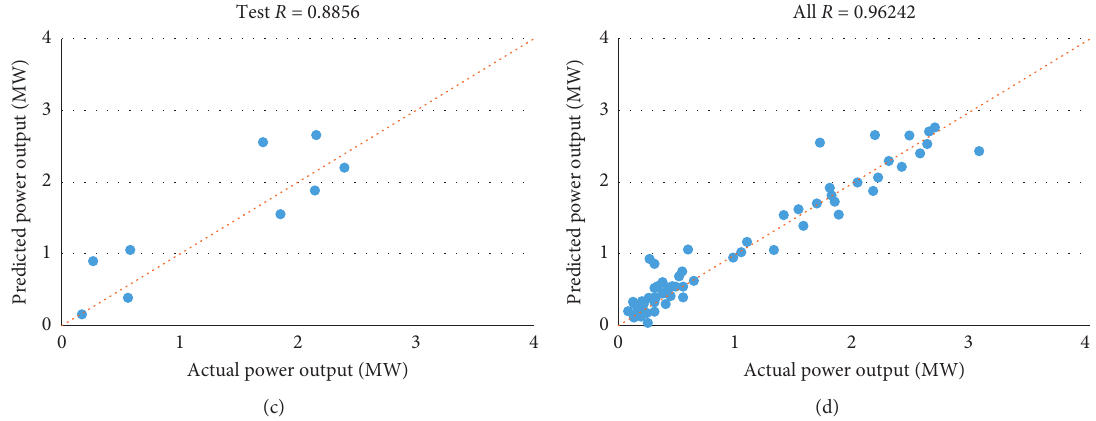
Figure 7: The predicted versus actual power for the SCG algorithm at the validation percentage of 10%: (a) training, (b) validation, (c) test, and (d) overall.